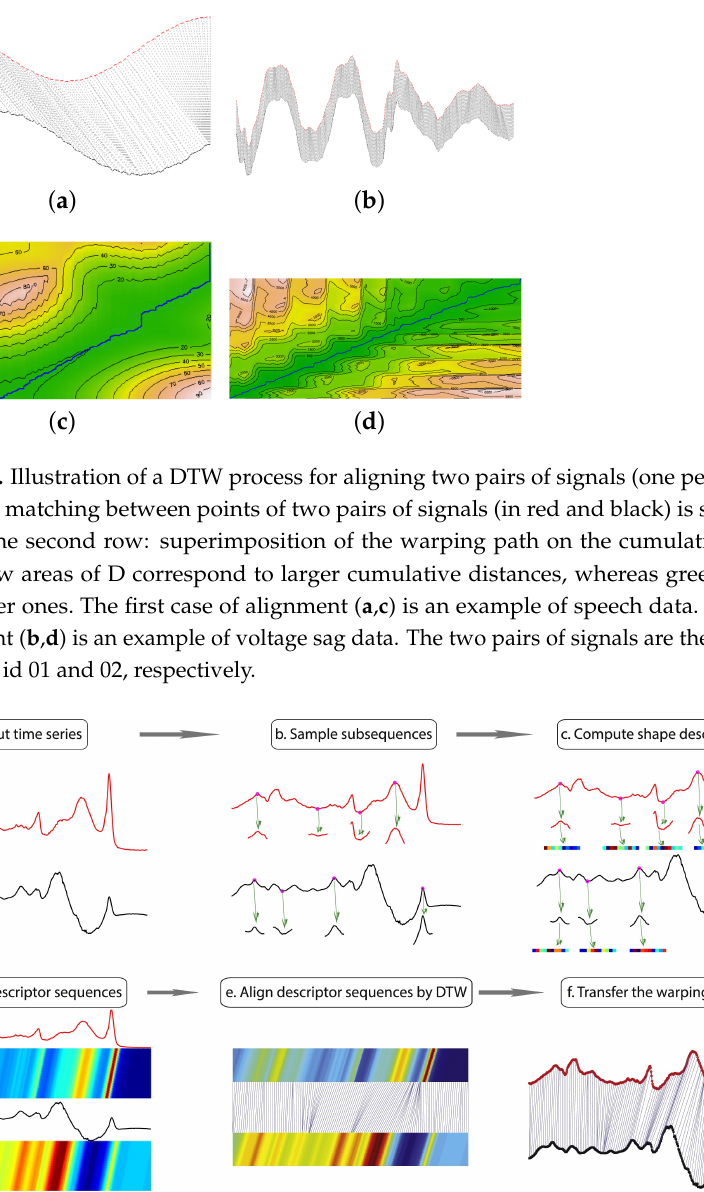
Figure 9. Pipeline of shapeDTW. shapeDTW consists of two major steps: encode local structures by shape descriptors, and align descriptor sequences by DTW. Concretely, we sample a subsequence from each temporal point and further encode it by some shape descriptor. As a result, the original time series is converted into a descriptor sequence of the same length. Then, we align two descriptor sequences by DTW and transfer the found warping path to the original time